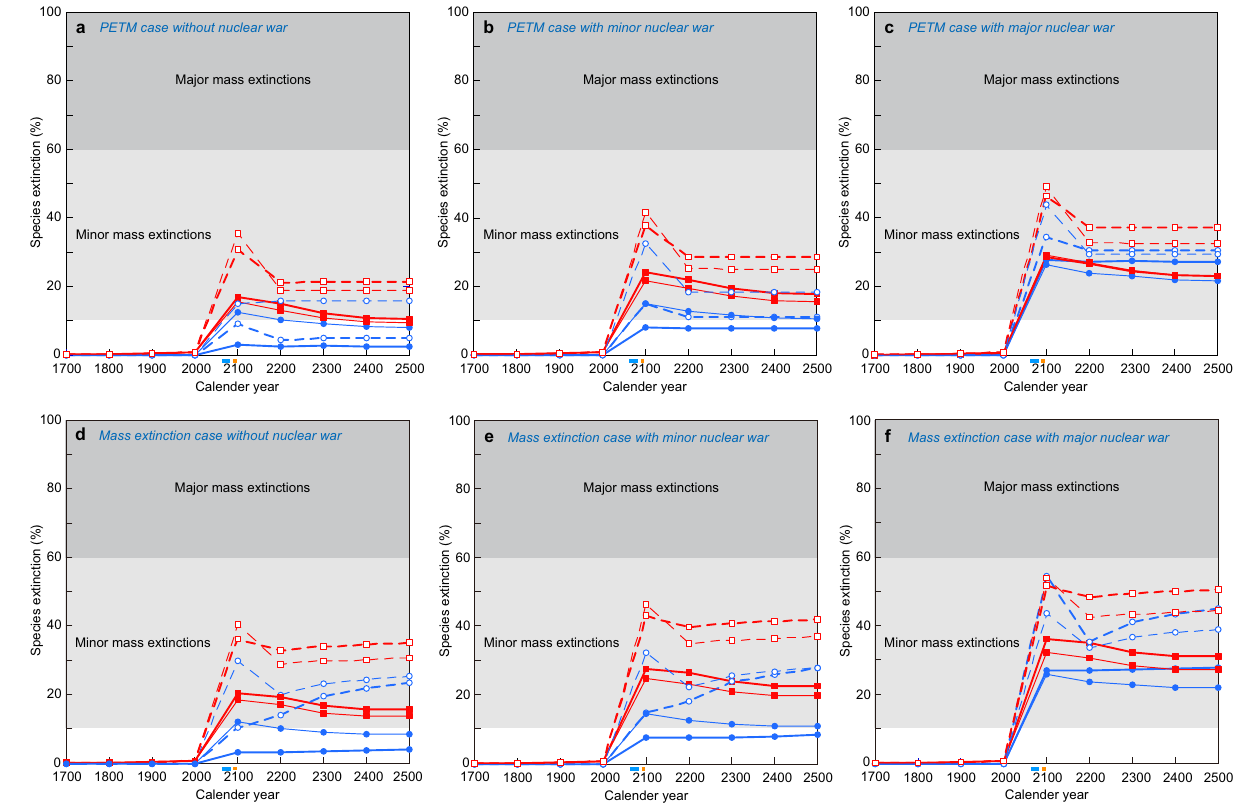
Figure 4. Animal species extinction percentages in the marine (blue circle) and terrestrial (red square) realms from CE 1700 to 2500 by all causes without nuclear war in the PETM case ( a ), those under minor nuclear war in the PETM case ( b ), those under major nuclear war in the PETM case ( c ), those without nuclear war in the mass extinction case ( d ), those under minor nuclear war in the mass extinction case ( e ), those under major nuclear war in the mass extinction case ( f ), in the most likely case (solid lines with closed dots) and the worst case (dushed lines with open dots). Thick lines: different contribution case. Thin lines: equal contribution case. The light blue and orange bars under the horizontal axes show the timing of the stoppage of GHG emissions in the most likely case and in the worst case, respectively. The maximum values of species extinction (%) correspond to the final species extinction magnitude. These data are shown in Supplementary Tables S5–S8. The maximum extinction magnitude occurred in ~ 2100 CE under no nuclear war